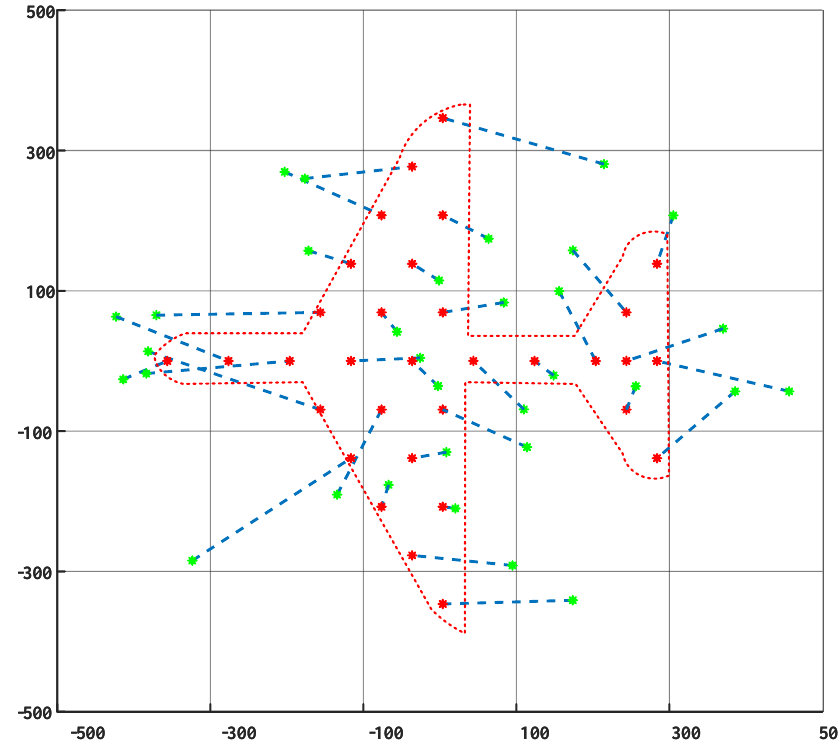
Figure 5. The X–Y perspective of topology shaping in aircraft shape.